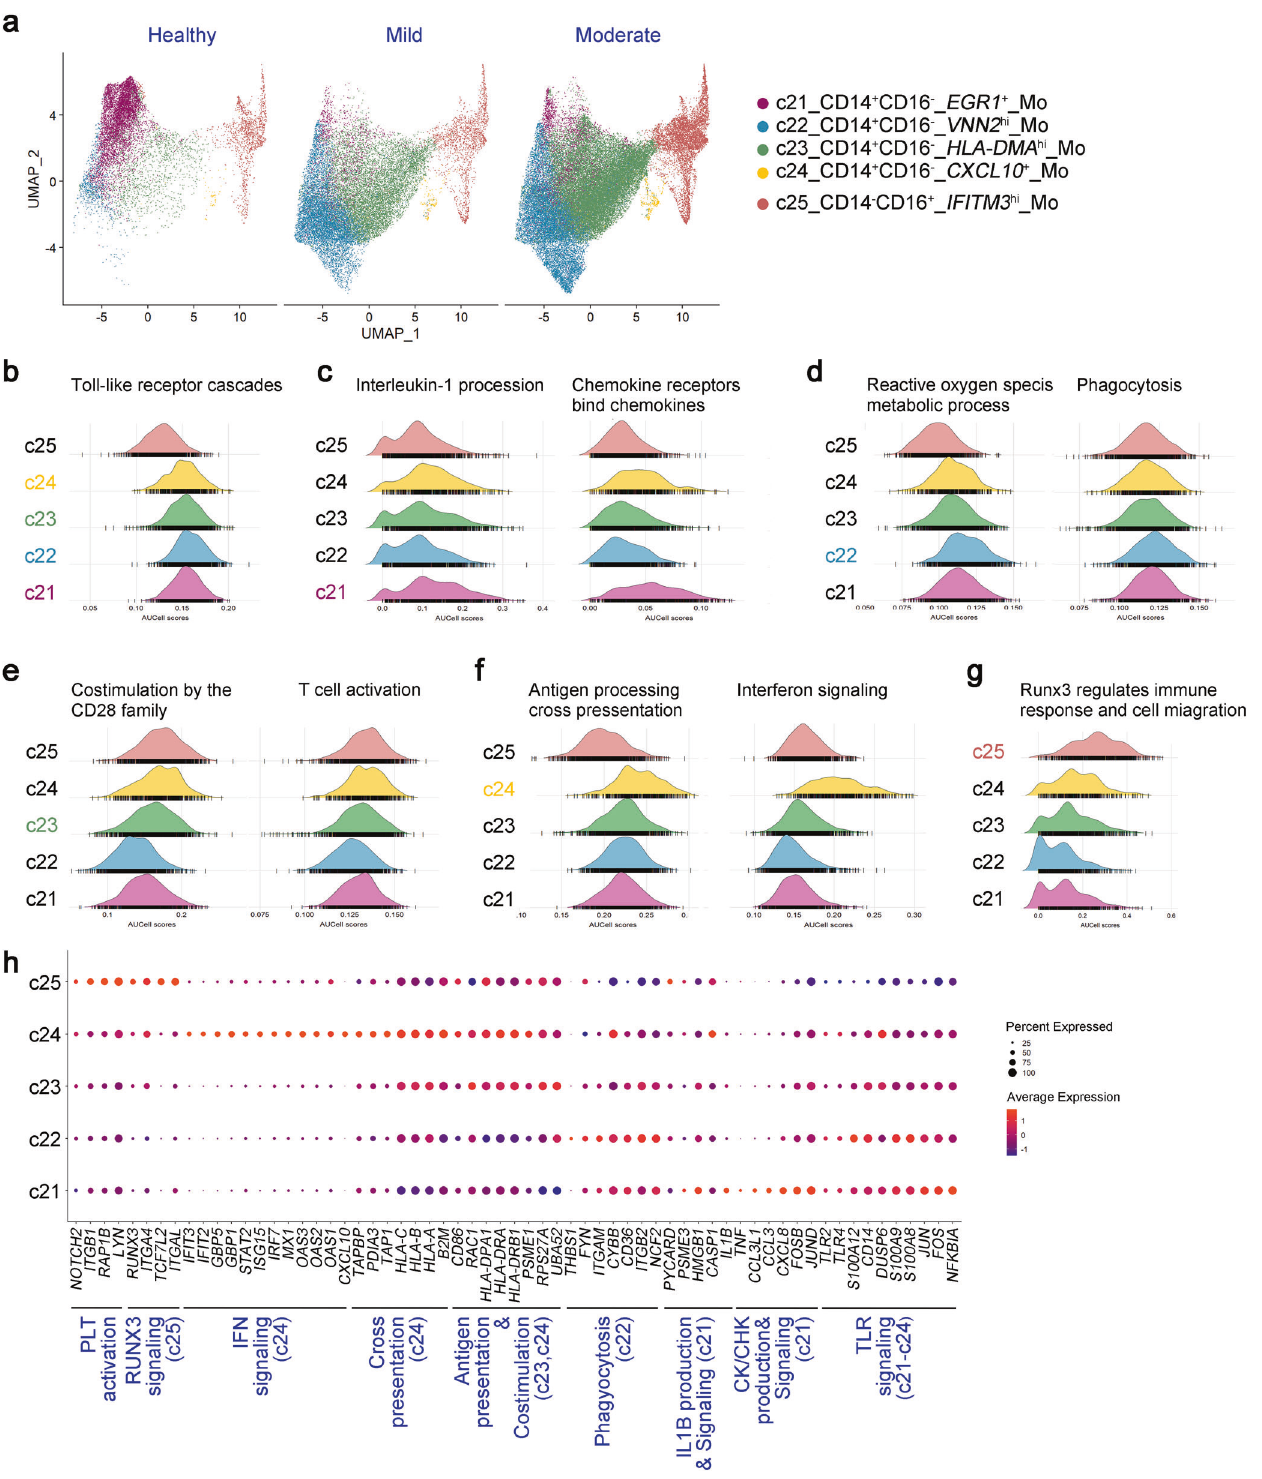
Fig. 3 Biological processes and signaling pathways enriched by the monocyte clusters in Omicron convalescents. a UMAP plots showing the distribution of all the monocyte clusters in convalescents after mild to moderate Omicron infection ( n = 5 for mild and n = 13 for moderate) and healthy donors ( n = 6). b AUcell plots showing the enrichment on TLR-mediated cascades by all monocyte clusters. c AUcell plots showing the enrichment on the production and responses to the signaling pathways of in fl ammatory cytokines and chemokines by all monocyte clusters. d AUcell plots showing the enrichment on the reactive oxygen species production and phagocytosis by all monocyte clusters. e AUcell plots showing the enrichment on the processes of antigen-presenting, T cell and B cell activation by all monocyte clusters. f AUcell plots showing the enrichment on the processes of IFN-mediated signal pathways by all monocyte clusters. g AUcell plots showing the enrichment on the responses to RUNX3-mediated immune response signal pathways by all monocyte clusters. h Dot plot depicting the expression of genes involved in the immune processes and signaling pathways enriched above by these monocyte clusters